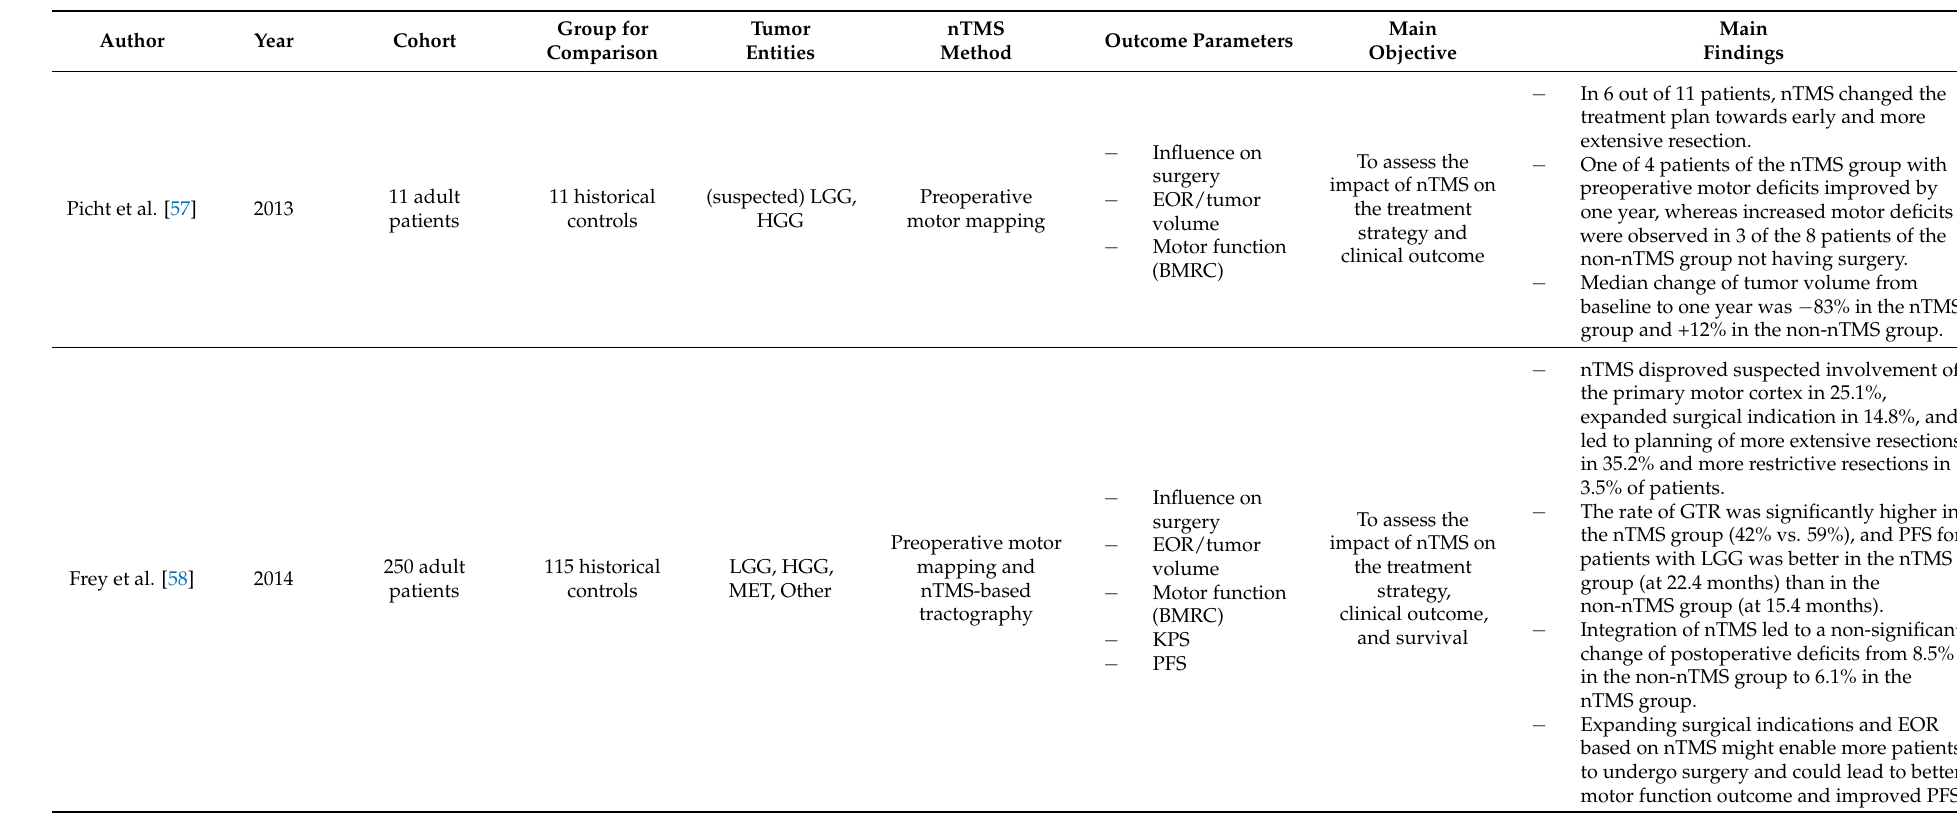
Table 3. Improvement of clinical outcome. This table outlines the studies published on improvements of clinical outcome through the use of motor mapping by nTMS (using an electric-field-navigated system) with or without additional nTMS-based tractography in patients harboring brain